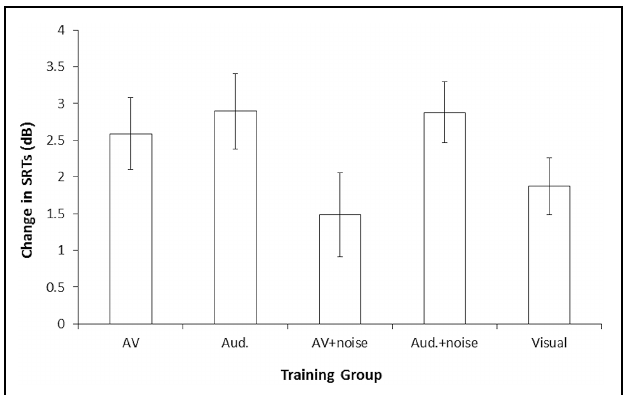
FIGURE 2 | Amount of perceptual adaptation to accented speech in Study 1: mean improvement in SRTs following training, per group (a higher change in SRTs indicates greater improvement). Error bars represent ± 1 SE. AV, audiovisual; Aud.,